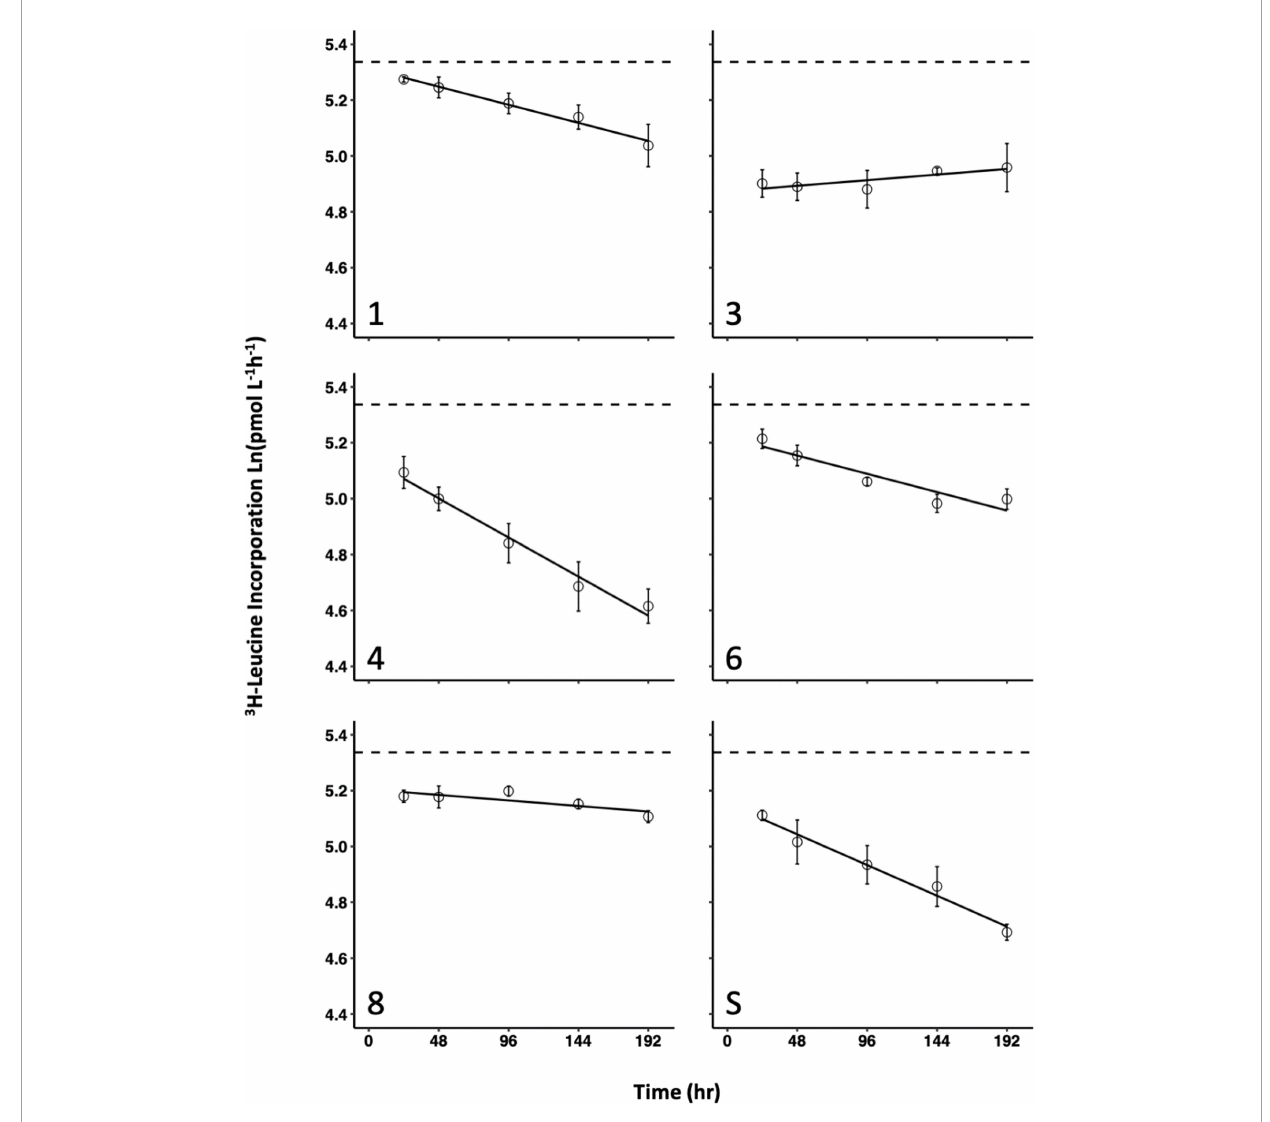
FIGURE3 Response of bacterial production ( 3 H-Leucine incorporation) with various solar exposure times for each of the 6 oils used in this study. Error bars represent the standard deviation of the mean of experimental replicates from the same WAF